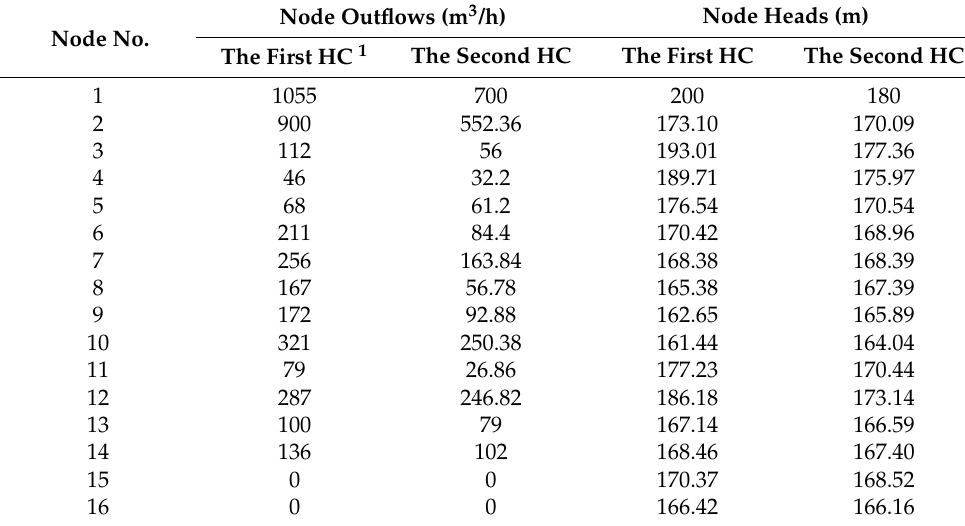
Table 4. “Known values” for the simple actual